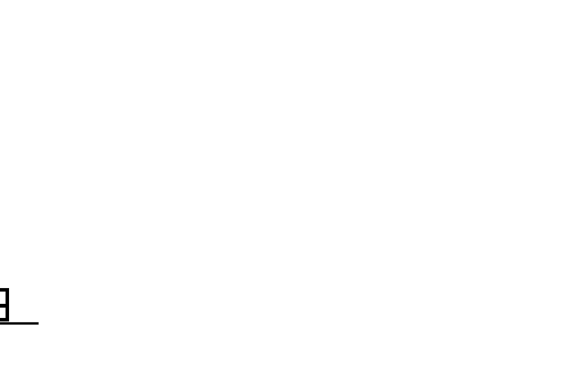
Figure 4. CXCL8 saliva levels are slightly decreased after PDT treatment. Shown are saliva concentrations (pg/ml) of CXCL8 before (day 1, D1) and after (day 28, D28) PDT treatment of oral OLP